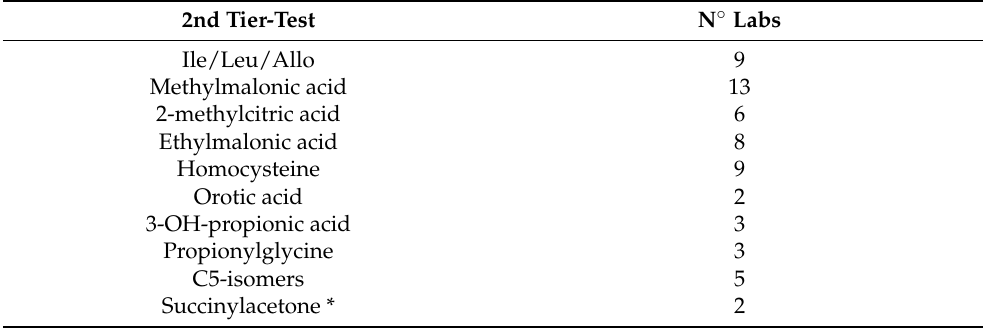
Table 2. Number of NBS laboratories performing 2nd